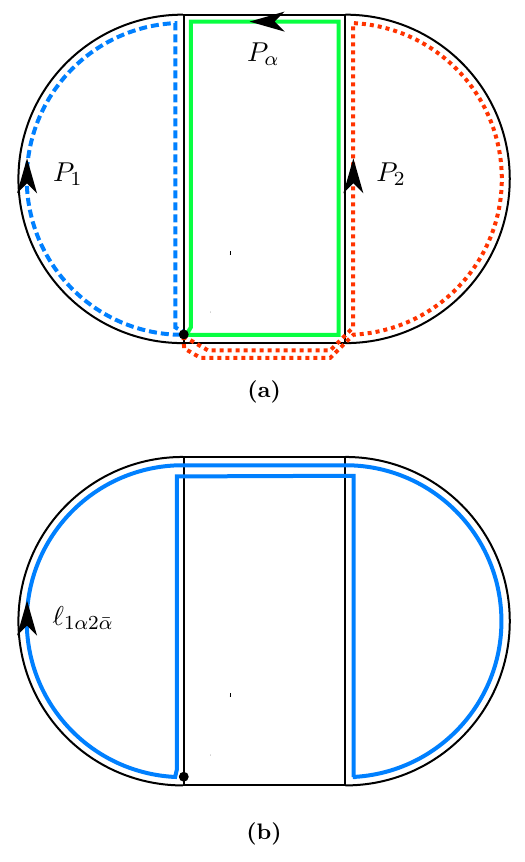
Figure 27. A 3-loop example illustrating that if ‘ 1 and ‘ 2 have no edges in common then the reduced loop ‘ 1 (cid:11) 2(cid:22) (cid:11) always includes all the edges in the loops ‘ 1 and ‘ 2 even if there are some intermediate cancellations. Figure 27a shows the three paths P 1 , P 2 and P (cid:11)